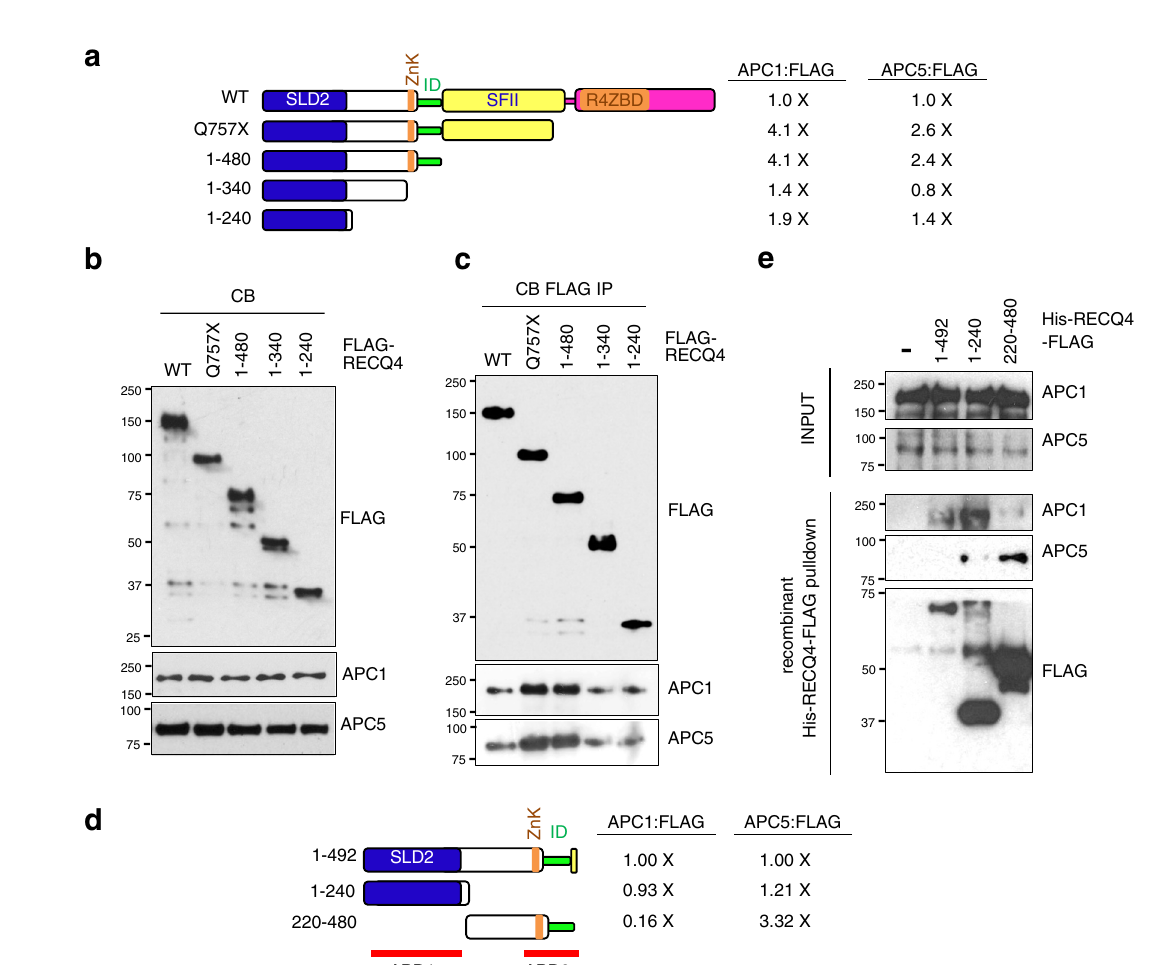
Fig. 3 | APC/C facilitates RECQ4 Q757X replication complex formation. a Flow cytometryanalysisofparentalHEK293cellsafterreleasefromnocodazoleblocking at the indicated time points. The cells were labeled with BrdU and co-stained for BrdU incorporation (Y-axis) and DNA content (propidium iodide [PI], X-axis). Per- centages of cells in G 1 , S, and G 2 /M phases are shown. Percentages of cells in G 1 , S, and G 2 /M phases are shown, with the highest percentage in each time point indi- cated in red. b Representative western blot analysis of the indicated proteins in whole-cell extracts (WCE; input; left) prepared from cells shown in ( a ) and of proteins co-immunoprecipitated (right) with RECQ4 using a rabbit anti-RECQ4 antibody at the indicated time points post-nocodazole (Noc) release. c Quanti fi cationof foldchangeinthe amount of the indicated co-puri fi ed proteins normalizedtothebaitproteinRECQ4comparedto0hin( b ).Ahighervalueonthe Y-axis corresponds to an increasing interaction. d Flow cytometry analysis of RECQ4 knockdown (KD) HEK293 cells stably expressing FLAG-tagged RECQ4 wild